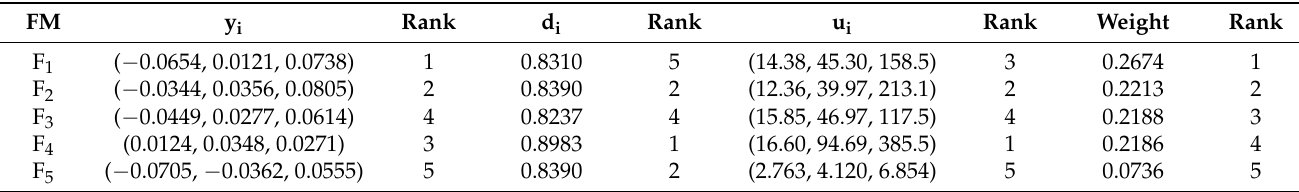
Table 7. The ranking alternatives according to extended fuzzy multi-objective optimization by ratio analysis plus full multiplicative form (EFMULTIMOORA).